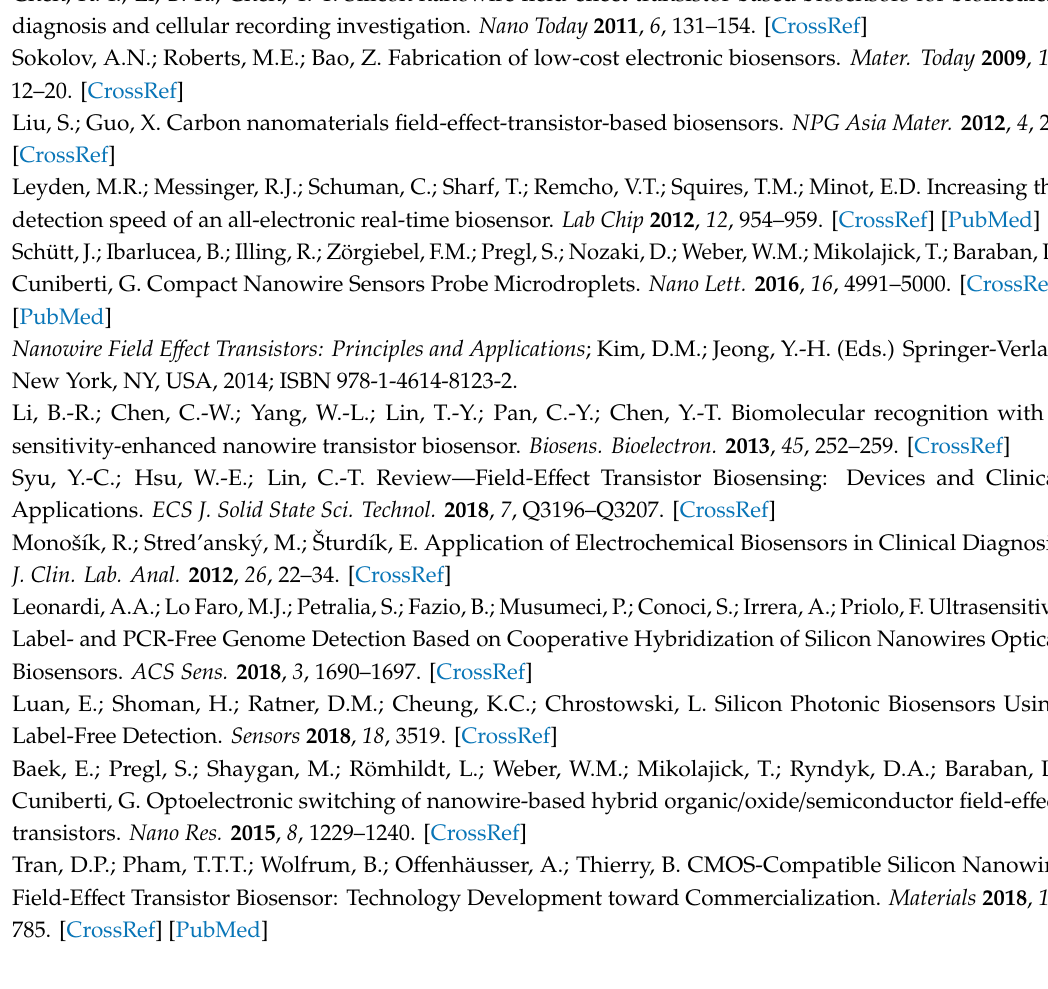
Figure S1: The experimental setup, including electrical circuit, Figure S2: Schematic drawings of the reaction, Figure S3: AFM height and phase images of di ff erently modified glass slides during modification with polymer brushes, Figure S4: (A) AFM height and phase images in two magnifications of SiNW FETs during modification with polymer PGMA and later PAA. White rectangles show area, where magnifications were taken from. White line indicates the position where height profile was extracted. (B) Height profile of SiNW FETs during functionalization with PGMA and PAA, Figure S5: Incubation of cells on PNIPAAM, PAA and glass